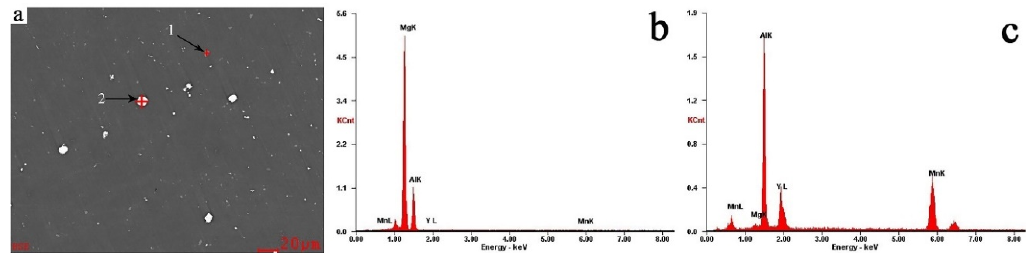
Table 3. The element contents of different intermetallic phase obtained by EDS.